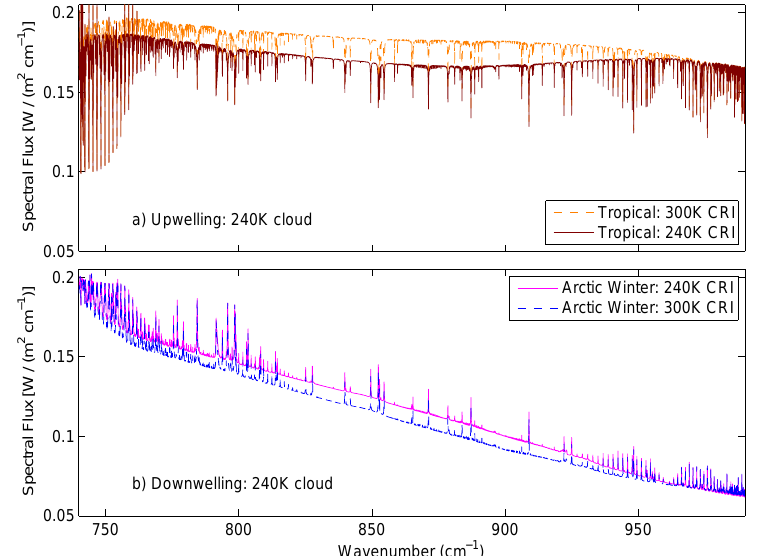
Fig. 3. Spectral flux for a cloudy atmosphere containing a single-layer liquid cloud at 240K, simulated using a conventional complex refractive index (CRI) based on measurements made at 300K and using a new CRI for 240K. The droplet effective radius was 5µm, and the cloud liquid water path was 8gm − 2 . (a) Upwelling spectral flux for a tropical atmosphere and (b) downwelling spectral flux for an Arctic winter